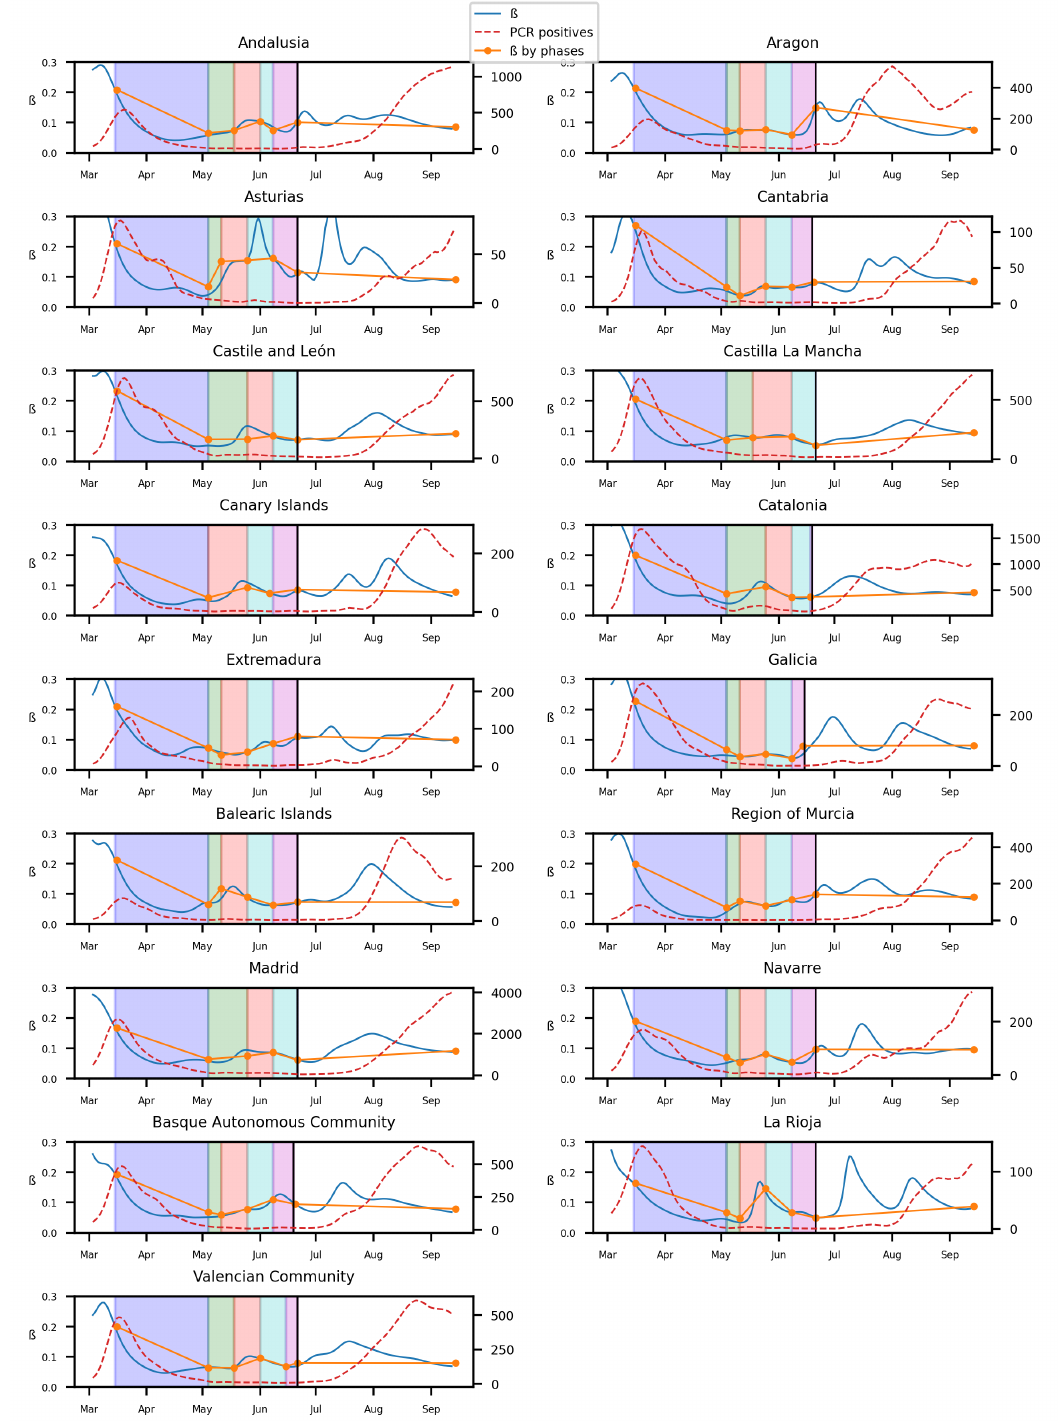
Figure 4. The y axis on the left on each subfigure correspond to β , while the one on the right to the number of new infected. Each background color represents a different stage of lockdown of Spain: Lockdown, phase 0,1,2,3. White background correspond to pre-lockdown and normality. Red dotted line: The value of new infected individuals at that day. Blue thin line: A 15-days average of β at that day calculated from Equation (8). Orange thick line: A linear regression of β during each